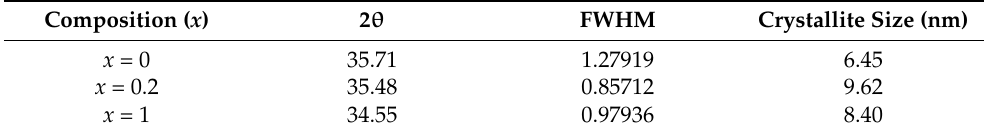
Table 1. XRD parameters for Ca x Mn 1- x Fe 2 O 4 ferrites, where x = 0, x = 0.2 and x = 1.